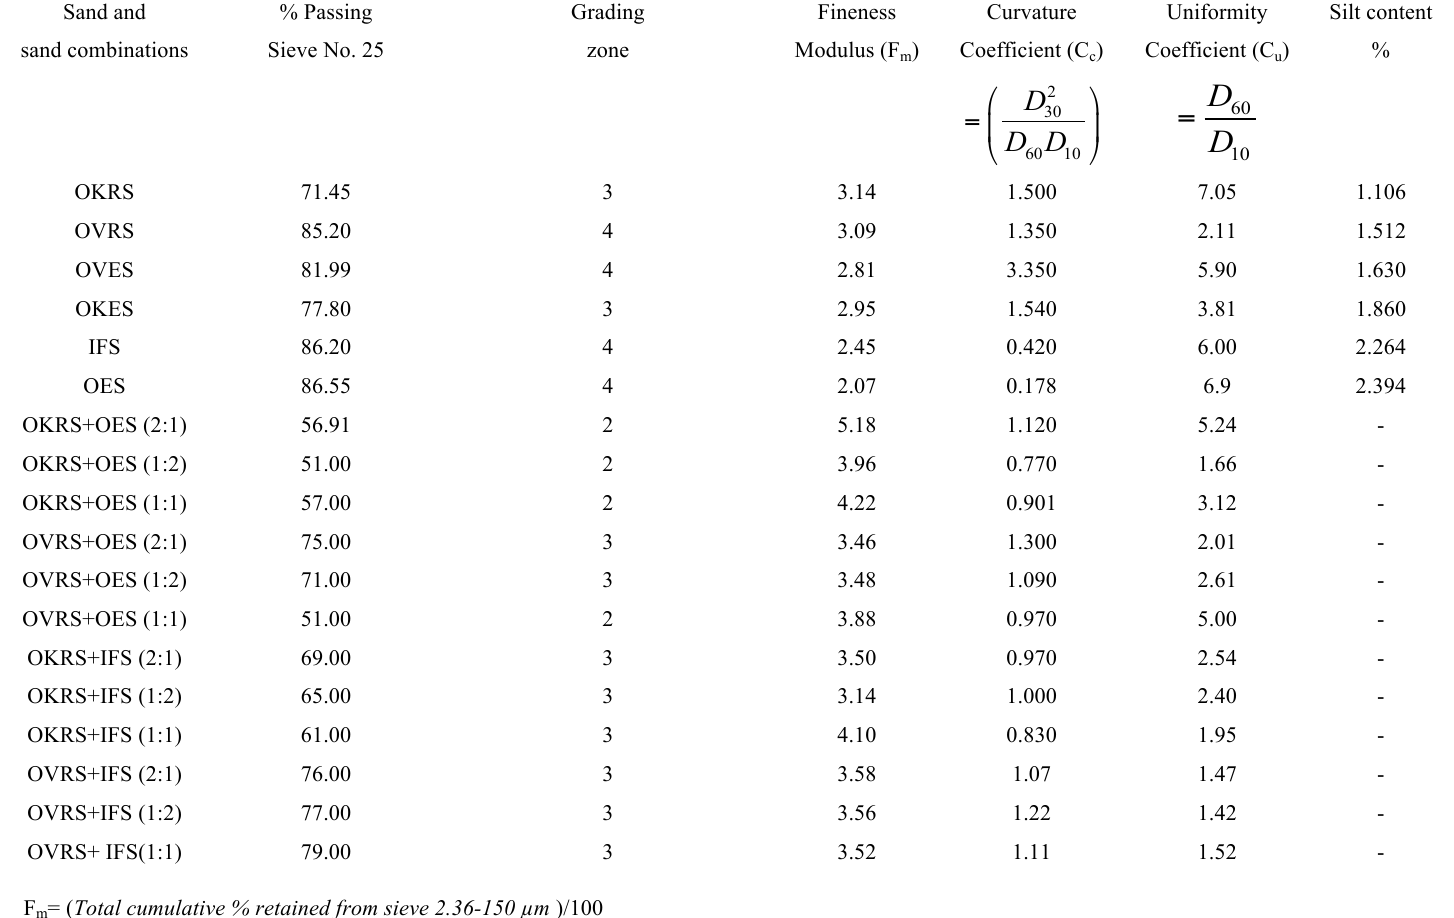
Table 5. Result of various sand and sand combinations grading parameters and silt content